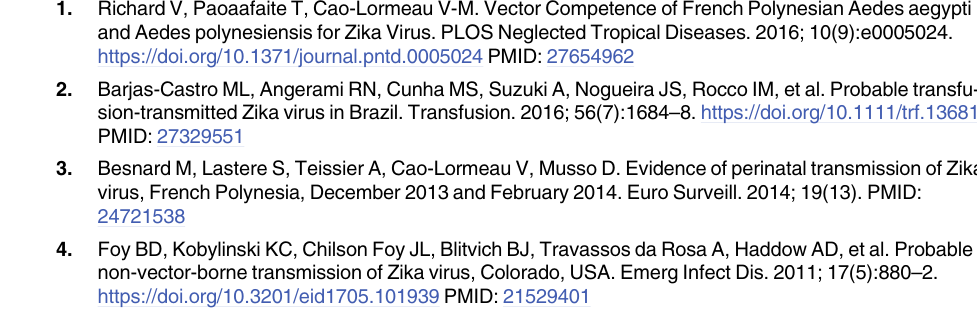
S1 Table. Probit analysis of 25 replicate serial dilution panel. Results of replicate testing of Polynesia isolate blinded panels presented as number of replicates reactive for related